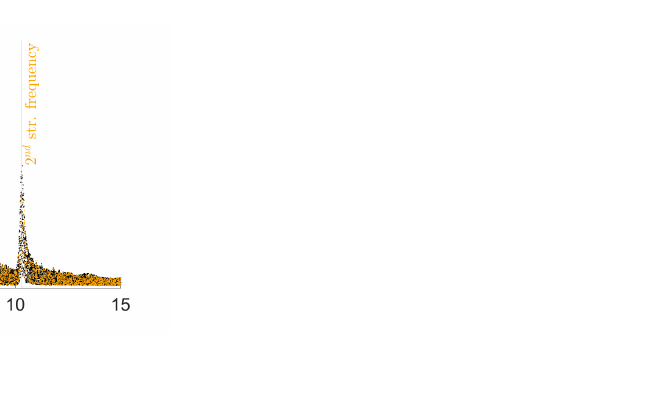
Figure 8. Two-storey shear building, configuration A. Reconstruction error for floor displacement v 1 via the standardized L 2 norm, as a function of the load frequency φ and for a varying value of P . In the charts, black dots refer to the training set, while orange dots refer to the validation set.